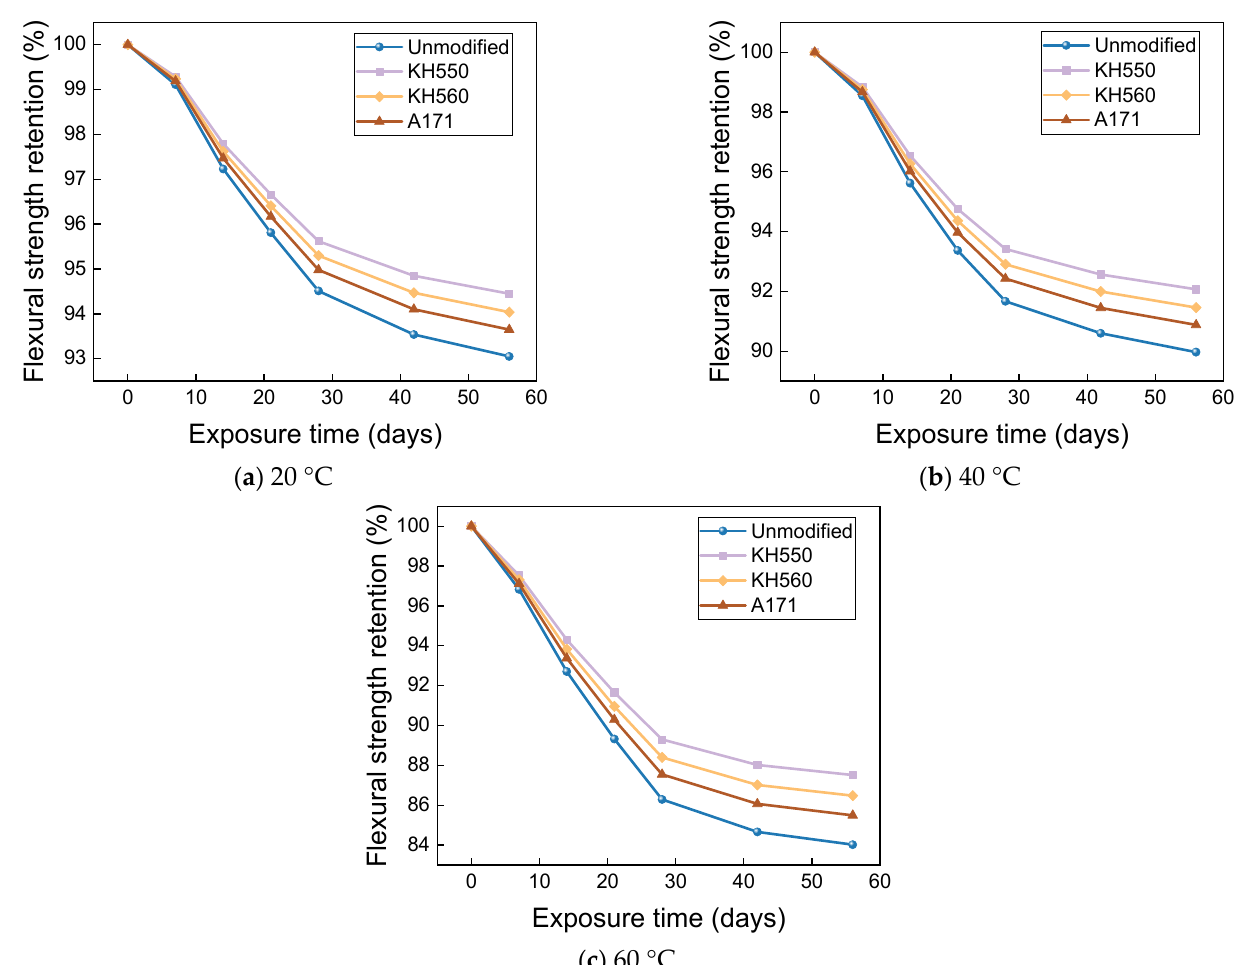
Figure 21. Flexural strength in a 3.5% NaCl seawater environment.